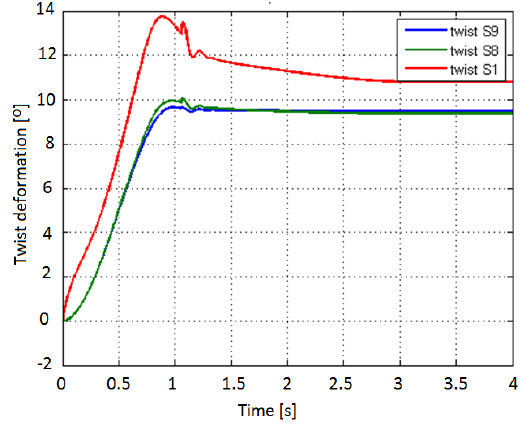
Fig. 9. SMA actuator activation time course